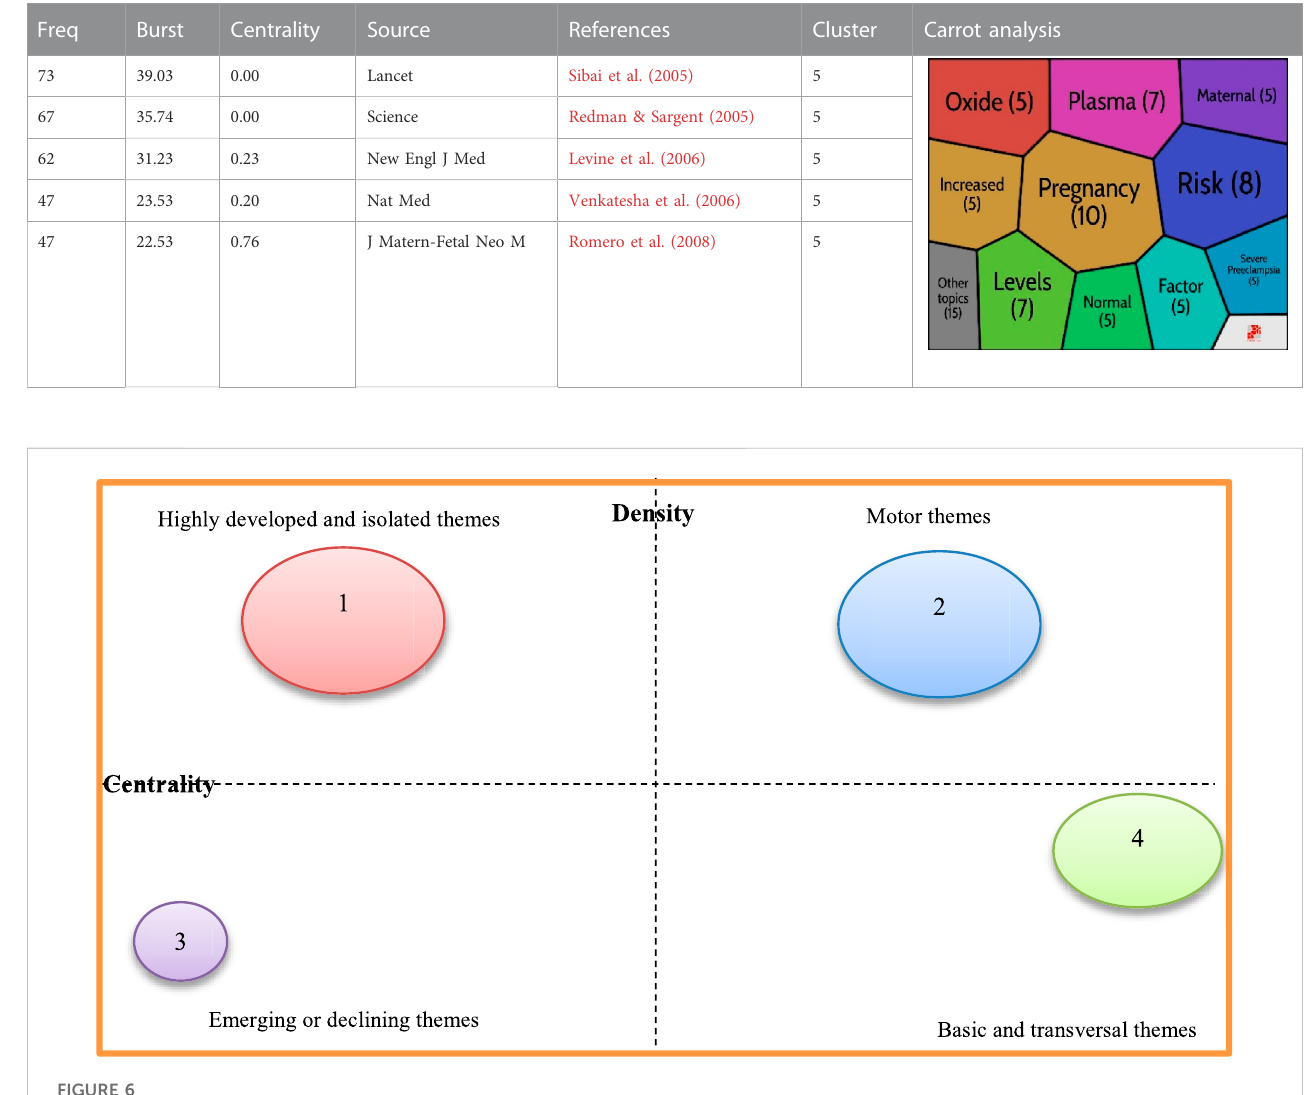
Strategic map in